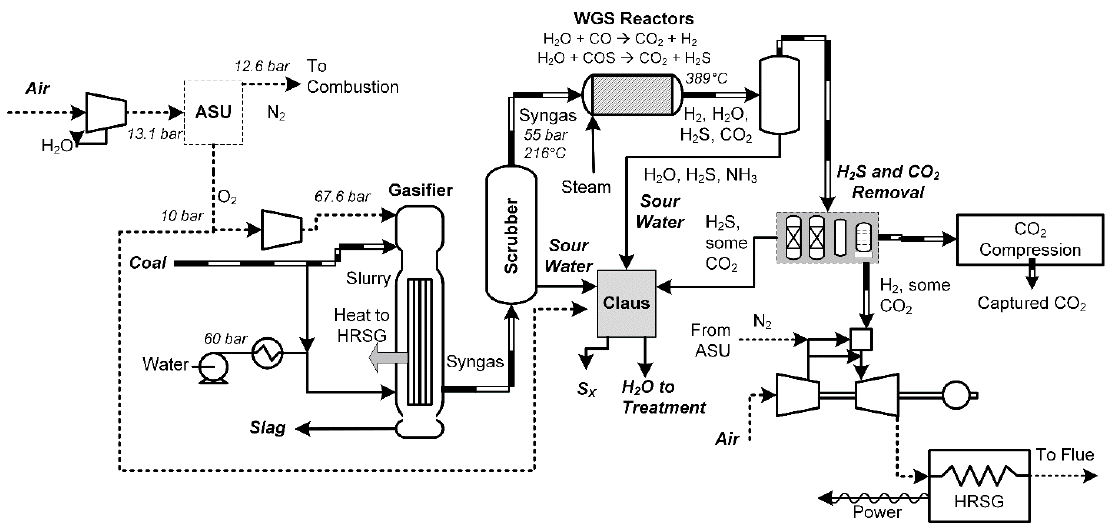
Figure 3. An example integrated gasification combined cycle (IGCC) process, based on a combination of [6,11,25,26].